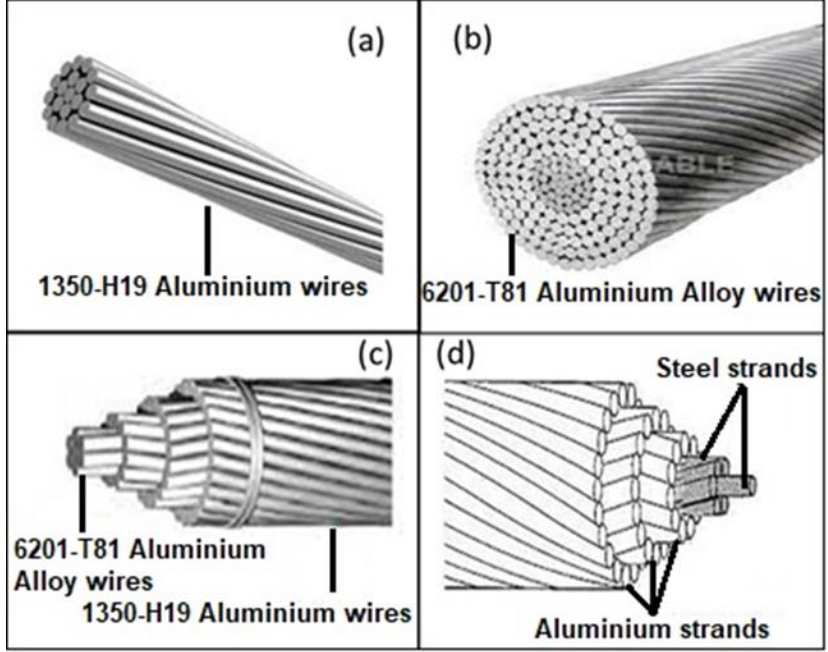
Figure 1. Al Transmission Conductors ( a ) AAC, ( b ) AAAC, ( c ) ACAR, ( d ) ACSR